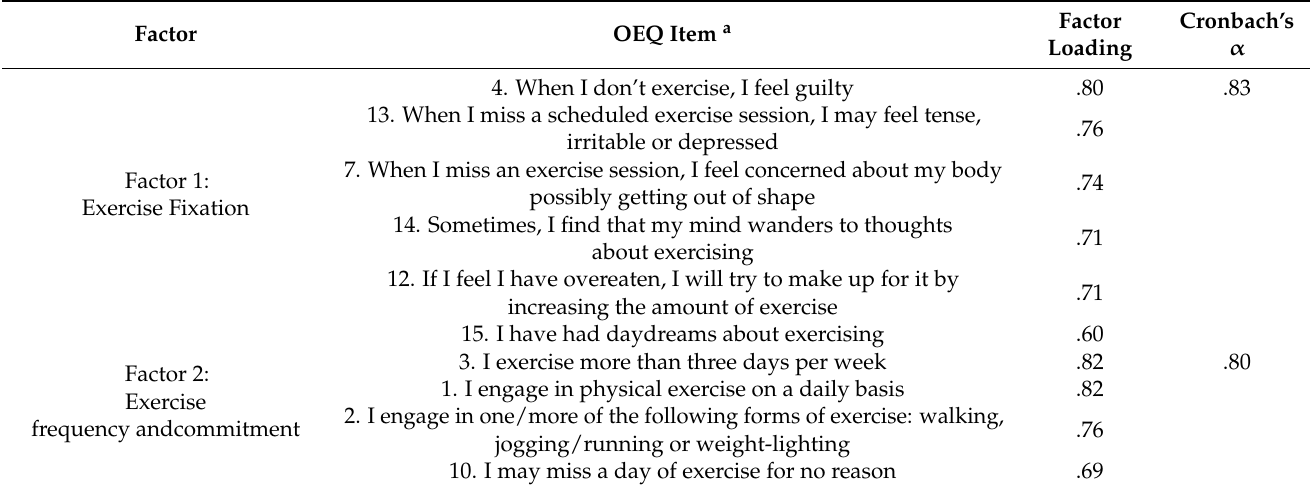
Table 1. Factor Loadings of 10 Remaining OEQ Items.